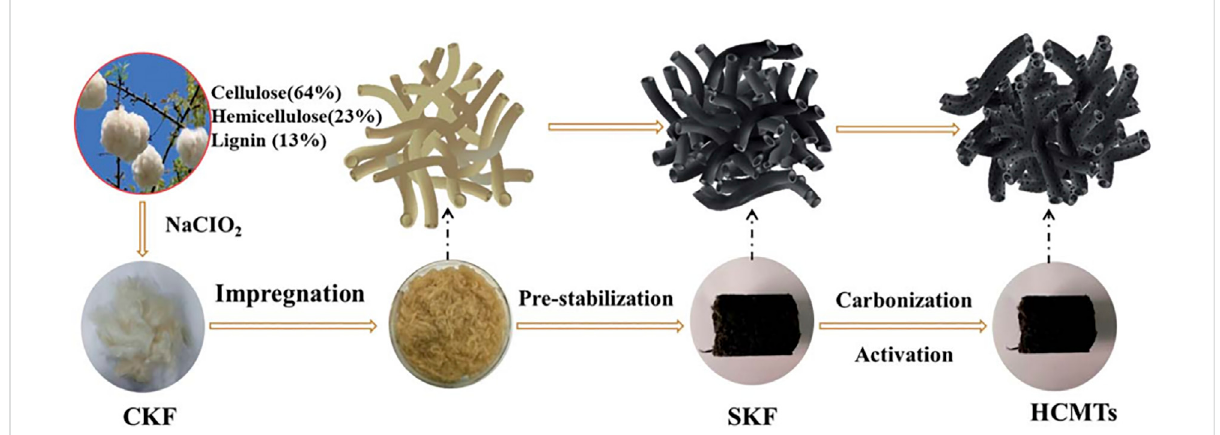
FIGURE 12 Schematic representation of the synthesis procedure for HCMTs (Cao et al., 2018).